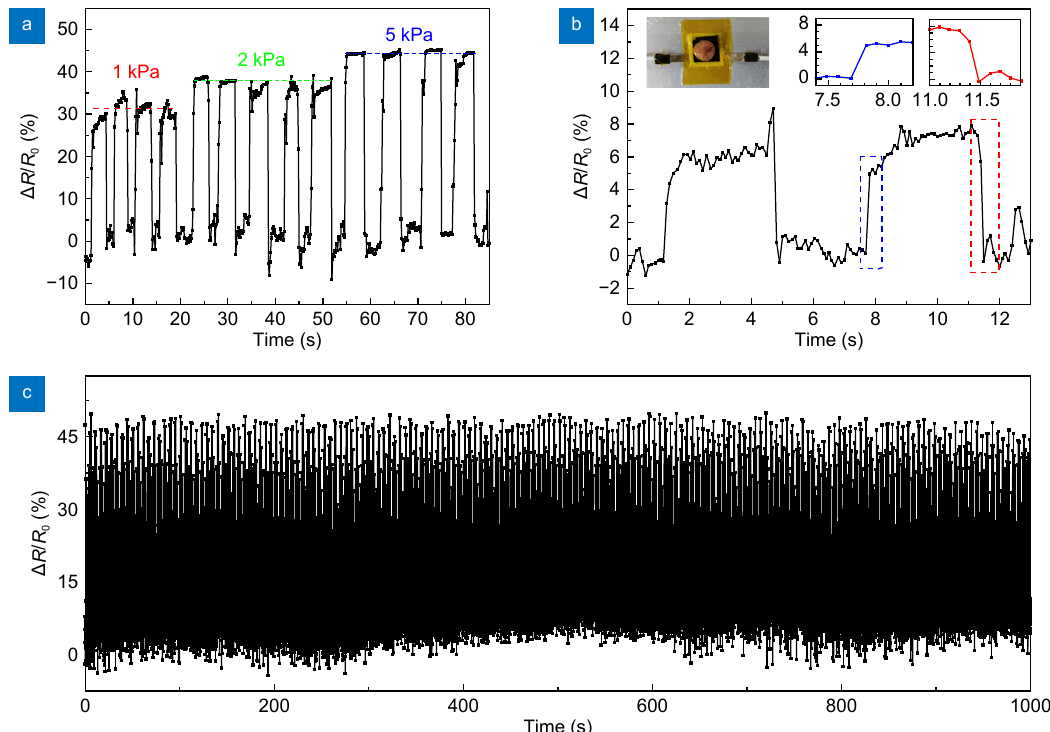
Fig. 7 | ( a ) Resistance variation toward step load. ( b ) Resistance variation toward pressure of a peanut. ( c ) Cycle stability within 1000 cycle times at 7 kPa pressure.